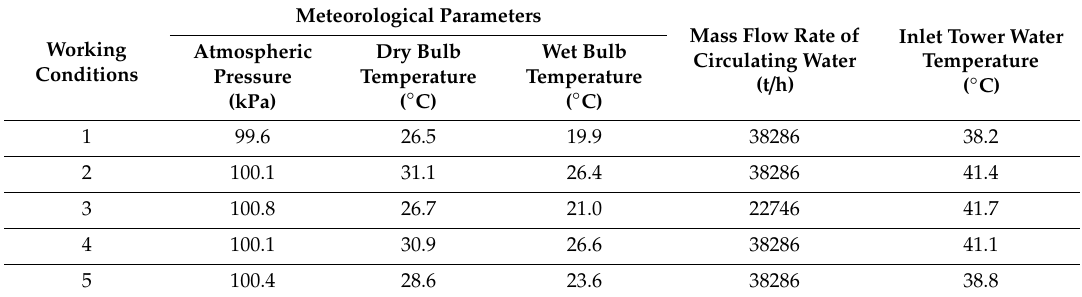
Table 4. Five di ff erent working conditions of 300 MW NDWCT.